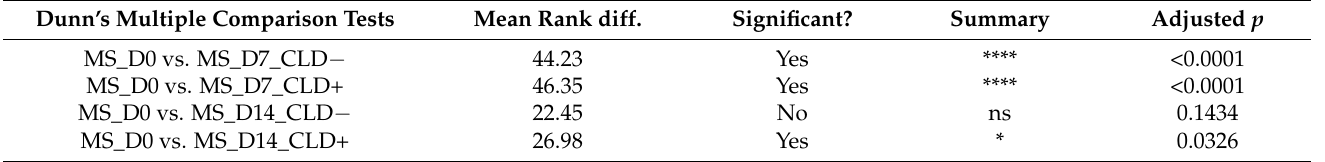
Figure 4. Boxplot type diagrams through which we followed the medians and interquartile range. Median values and statistical significance are mentioned in the graph. Comparison of CLD exposure effects on IL-17A secretion by PBMCs harvested from RRMS patients with a disease duration of >12 months on day 0 with days 7 and 14. ( A ) Comparison between the level of IL-17A secreted by PBMC ex vivo and on day 7 of the study in the absence of exposure to CLD; ( B ) Comparison between the level of IL-17B secreted by PBMC ex vivo and 7 days after exposure to CLD; ( C ) Comparison between the level of IL-17A secreted by PBMC ex vivo and on day 14 of the study in the absence of exposure to CLD; ( D ) Comparison between the level of IL-17A secreted by PBMC ex vivo and 14 days after exposure to CLD. Table 5. Comparison of CLD exposure effects on TNF- α secretion by PBMCs from RRMS patients with a disease duration of >12 months on day 0 with days 7 and